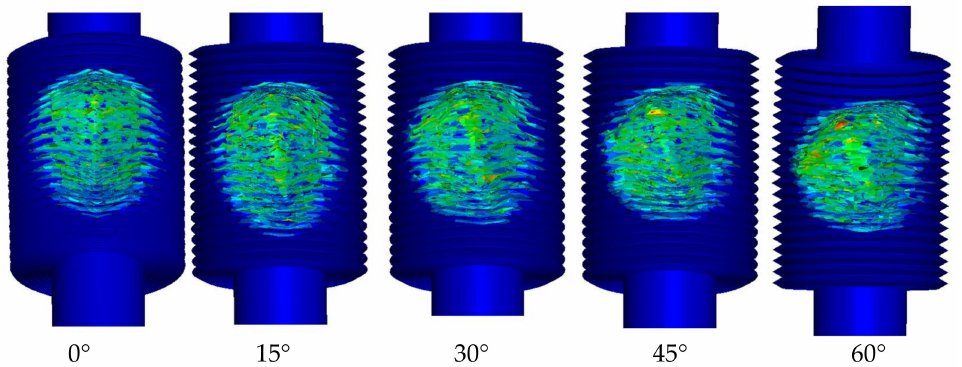
Figure 20. Contours of effective plastic strain of the reinforced pipe under different impact